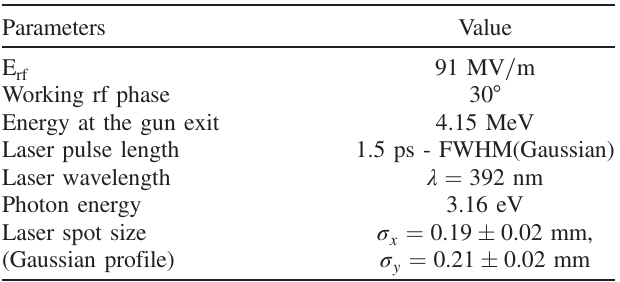
TABLE I. Photoinjector settings and laser parameters for QE and beam emittance measurements.